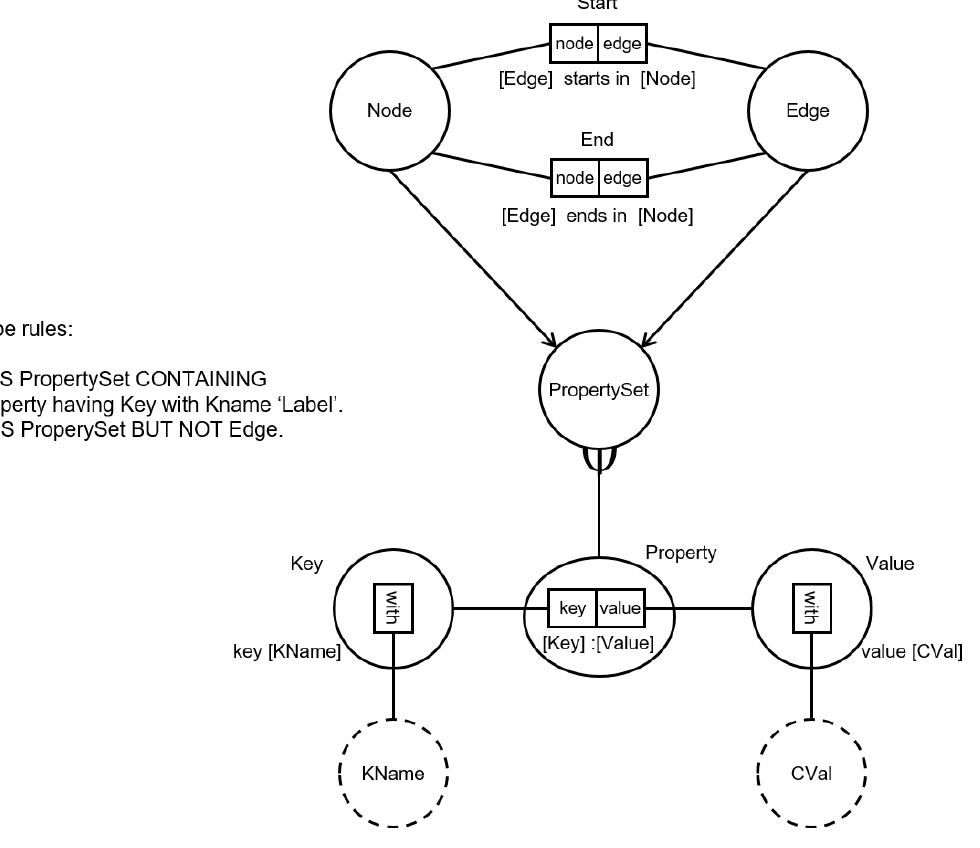
Figure 10. Meta scheme for graphical